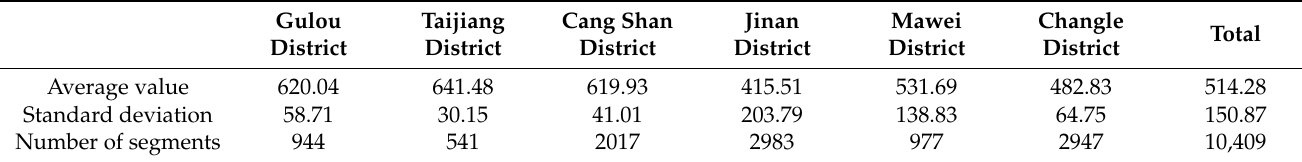
Figure 6. Road integration in Fuzhou city. Table 1. Fuzhou city road integration statistics table.